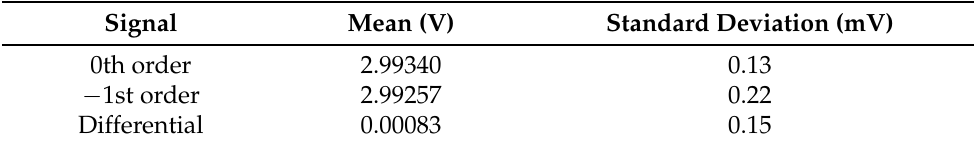
Figure 7. Time traces associated with the first injection of solution, s 0 , with natural noise. Table 3. Mean (time-averaged) differential output voltage and standard deviation over time of the differential output voltage associated with the injection of solution, s 0 , shown in Figure 7 between 138 and 222